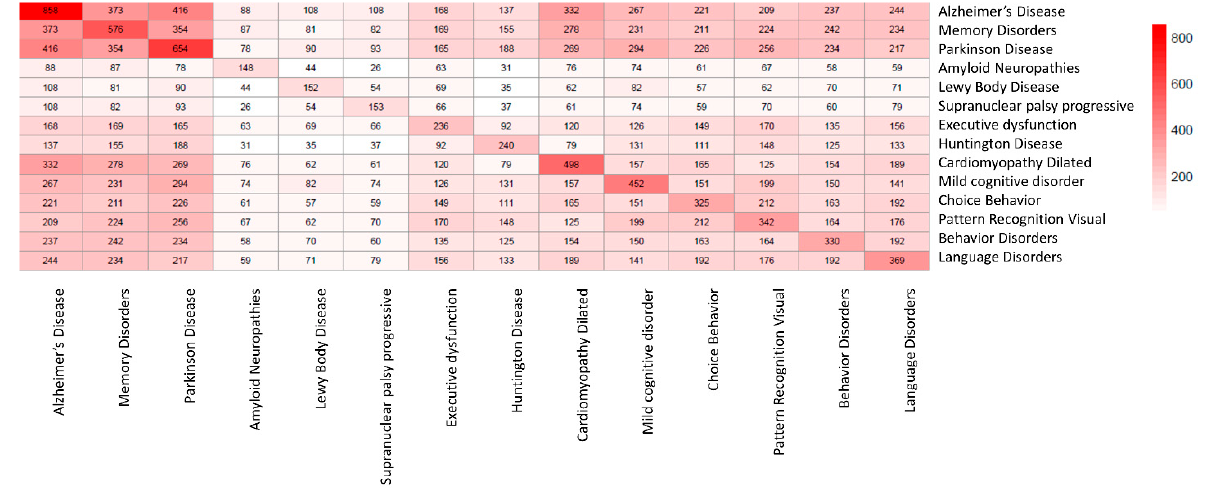
Figure A2. Number of repurposable drugs. Heatmap showing the number of drugs predicted to be repurposable for each disease (on the diagonal) and the number of drugs shared among each pair of diseases. Heatmap color scales with the number of drugs, increasing from white to red.